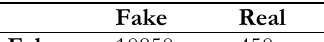
Table 5. Test classification